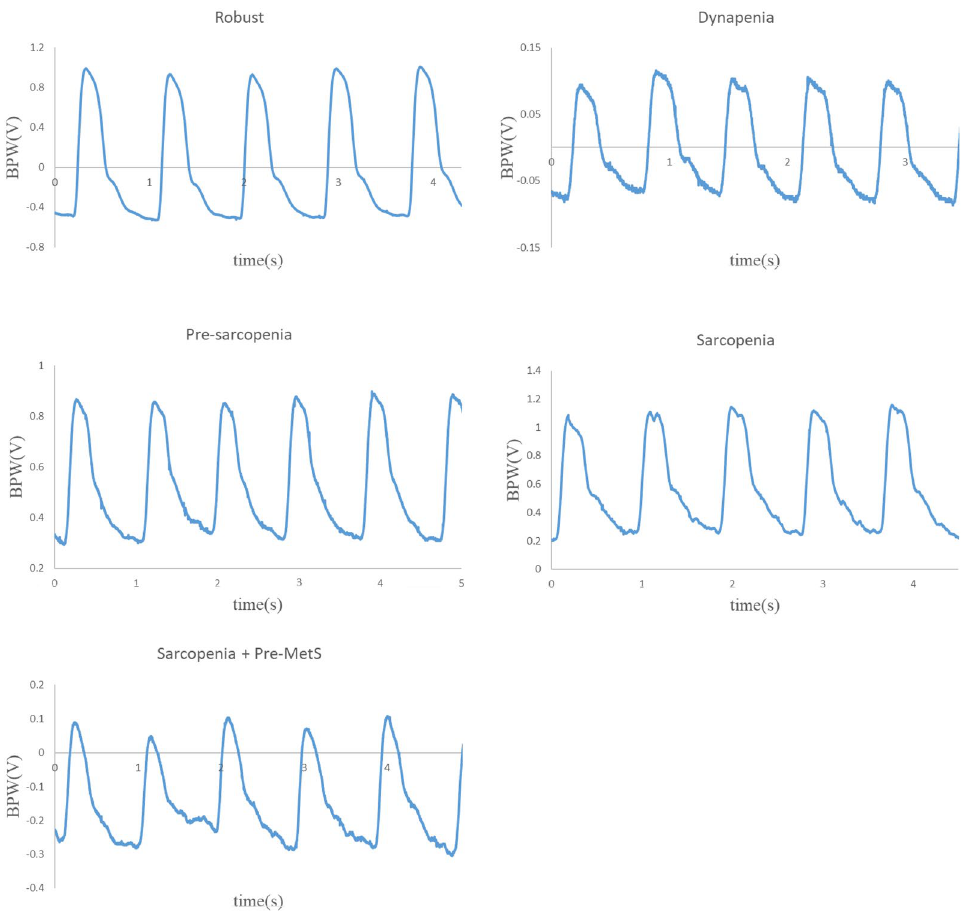
Figure 1. Typical BPW waveforms measured (in arbitrary